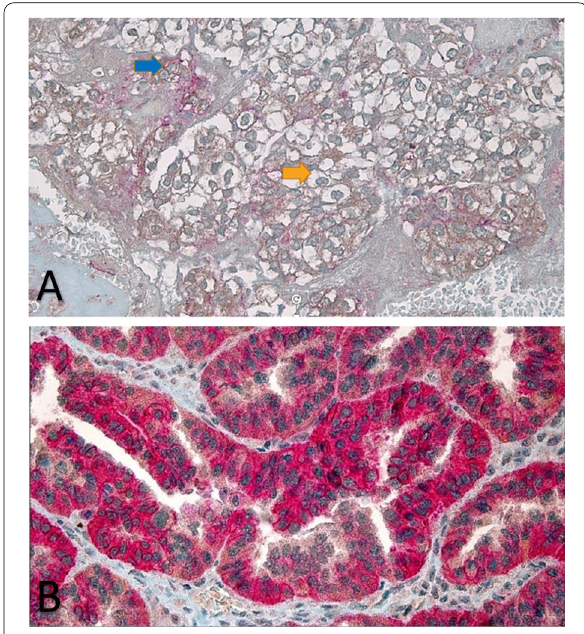
Fig. 3 CD44 + /CD24 − expression in ovarian cancer tissue (400 magnification). CD44 + cells have brown cell membrane (orange arrow). CD24 + cells have red cytoplasm and cell membrane (blue arrow). CD44 + /CD24 − cells have a more dominant brown color than red color. A Chemoresistant ovarian cancer tissue, brown staining predominating over red. B Chemosensitive ovarian cancer tissue, almost all cells are colored